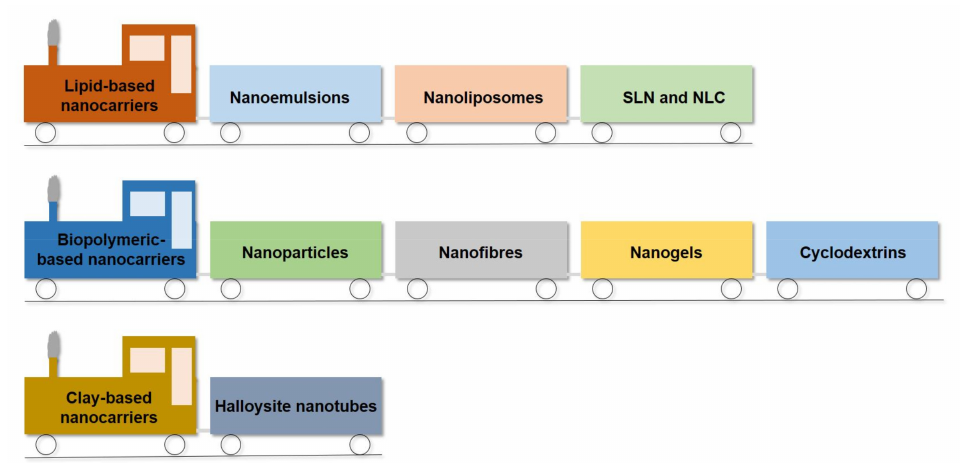
Figure 2. Classification of main nanocarriers used for active packaging development. SLN—solid lipid nanoparticles; NLC—nano-structured lipid